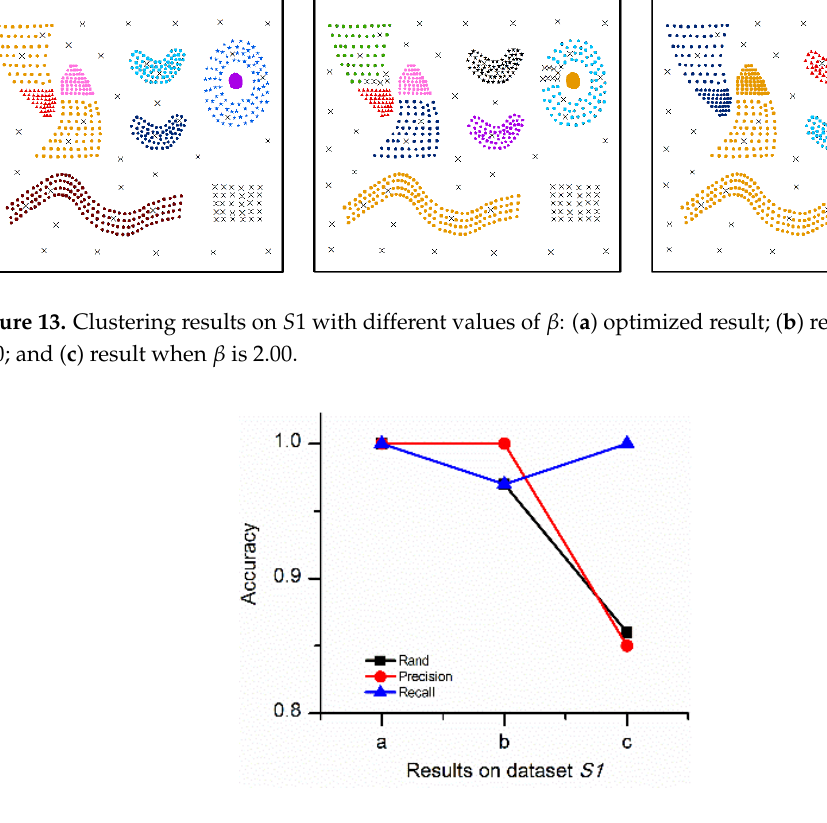
Figure 14. Accuracy values of the clustering results in Figure 13.